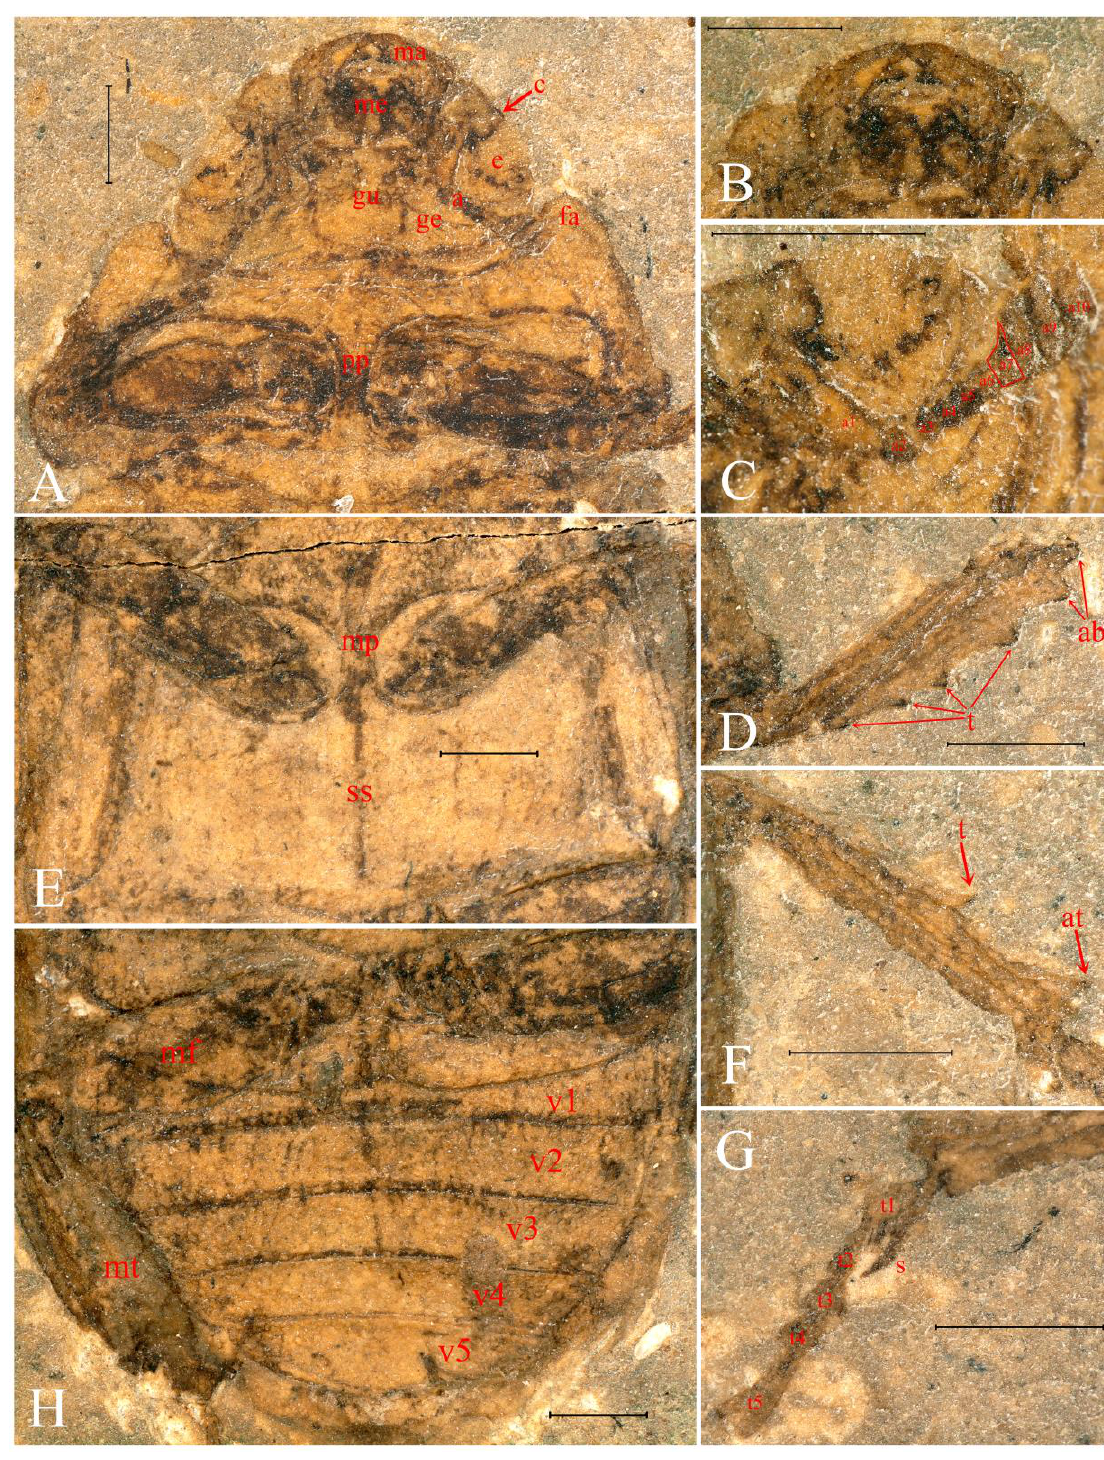
Figure 3. Morphological details of Prolucanus beipiaoensis gen. et sp. nov. (holotype, NIGP176633). ( A ) Head ventral and prosternum; ( B ) mandibles and mentum; ( C ) antenna; ( D ) protibia; ( E ) mesoster- num and metasternum; ( F ) mesotibia; ( G ) mesotibial apical spur and mesotarsus; ( H ) abdomen and hind leg. Abbreviations: a, antenna; a1–10, antennomere 1–10; ab, apex bifurcate; at, apical tooth; c, canthus; e, eye; fa, front angle; ge, gena; gu, gula; ma, mandible; me, mentum; mf, metafemur; mp, mesosternal process; mt, metatibia; pp, prosternal process; s, spur; ss, sutura sternalis; t, tooth; t1–5, tarsomeres 1–5; v1–5, ventrite 1–5. Scale bars = 1